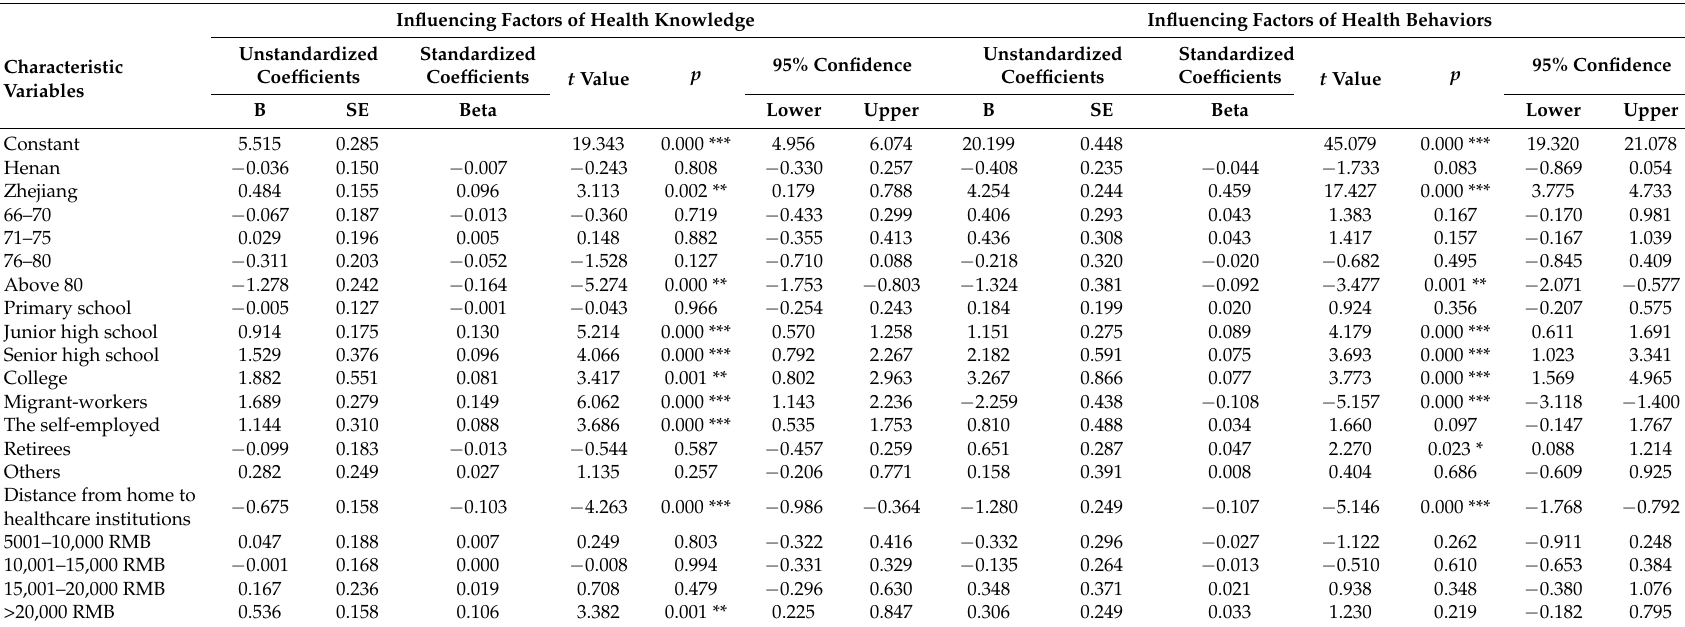
Table 5. Multiple − linear regression analysis of factors of health knowledge and behavior among the elderly in sample